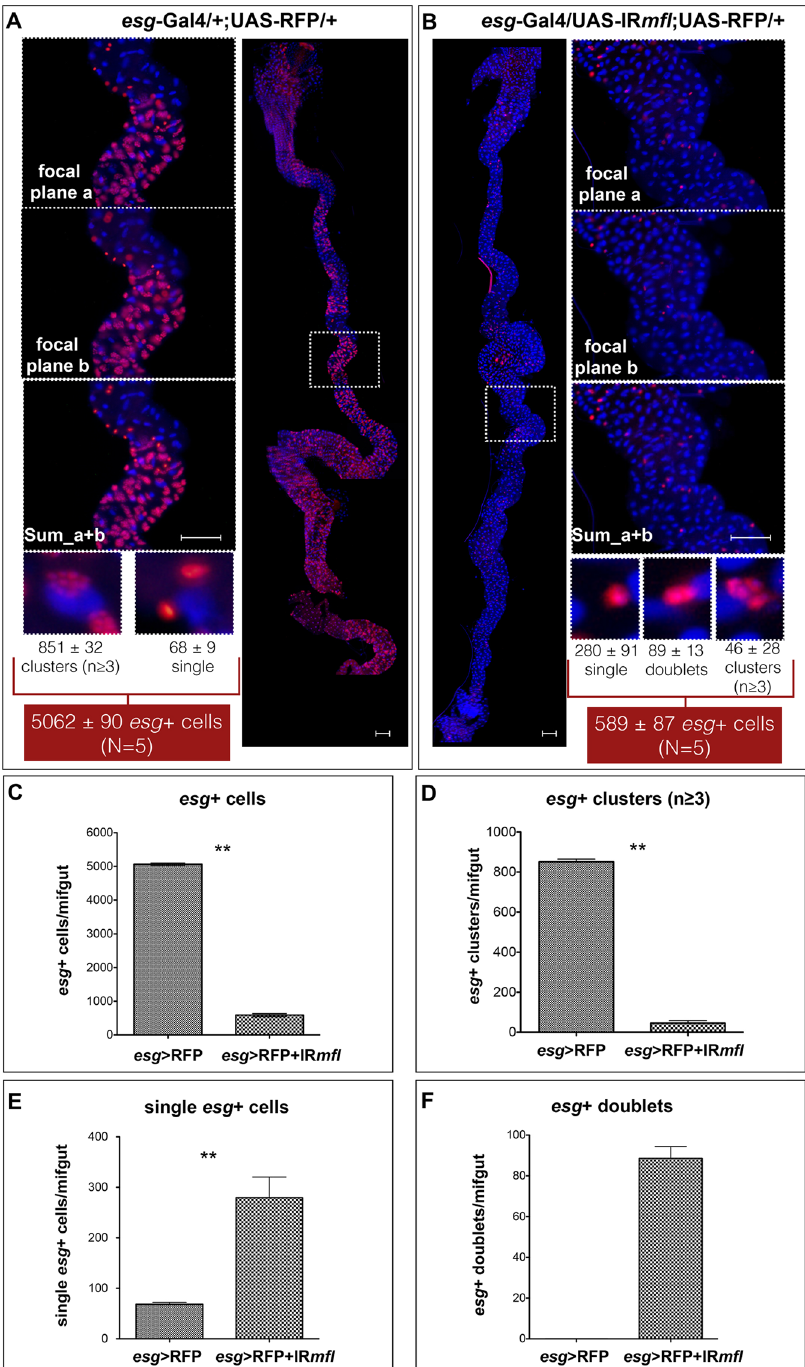
Figure 3. Quantification and organization of esg + cells in whole midguts. Epifluorescence images of control ( A ) and silenced ( B ) midguts at the third larval stage. Scale bars: 100 µ m. The white-hatched squares indicate fields whose magnifications are shown aside, as either single focal planes (a,b) and as sum of the two focal planes (a + b). Organization of esg + cells, marked by RFP expression, was analyzed in 5 control and 5 silenced midguts. DAPI is in Blue. Histograms represent the total number: of the esg + cells, regardless the specific kind of organization ( C ); of esg + clusters ( D ); of esg + singlets ( E ); and of esg + doublets ( F ) in control and silenced midguts. Mann-Whitney test was applied for statistical